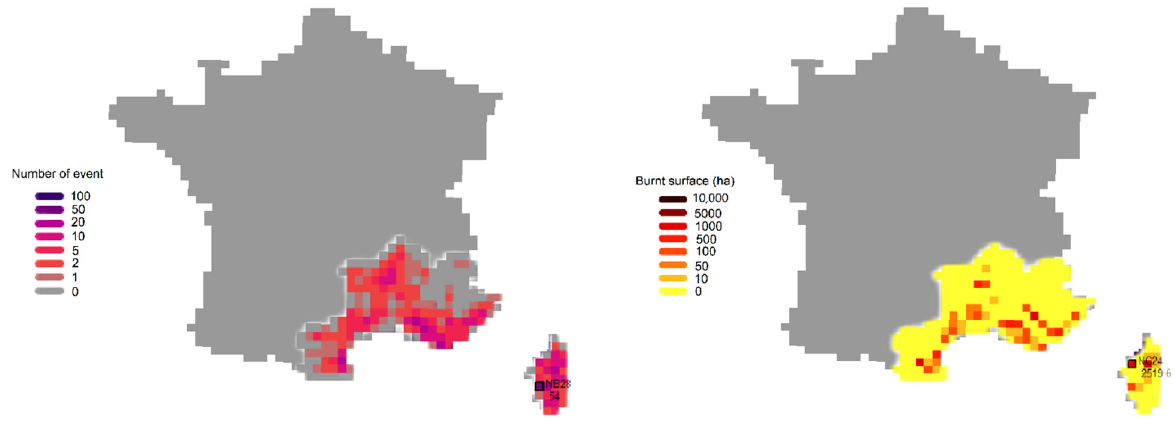
Figure 5. The two maps exemplify the diversity of the fire occurrence ( left ) and burnt surface ( right ) according to each DFCI mesh for the summer period in 2005.